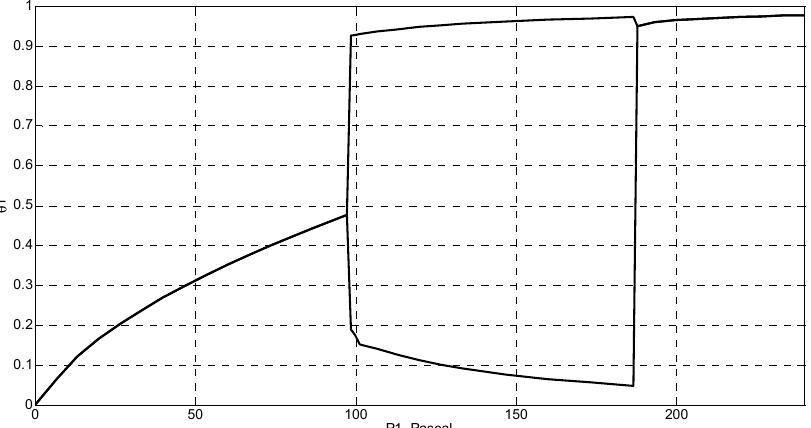
Figure 5. Amplitude values at stationary superficial fractional coverage of carbon monoxide versus carbon monoxide partial pressure [44].